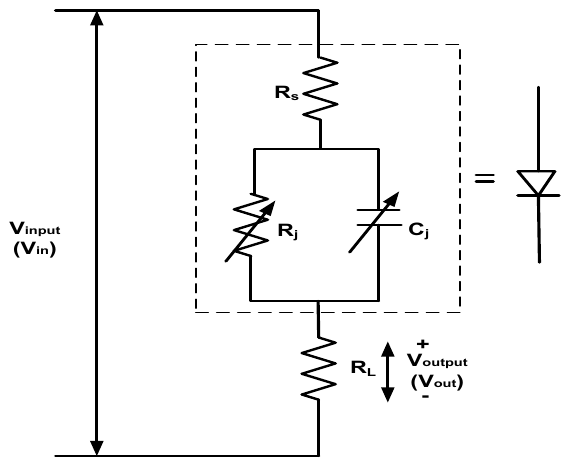
Figure 4. Equivalent model of the measurement setup.